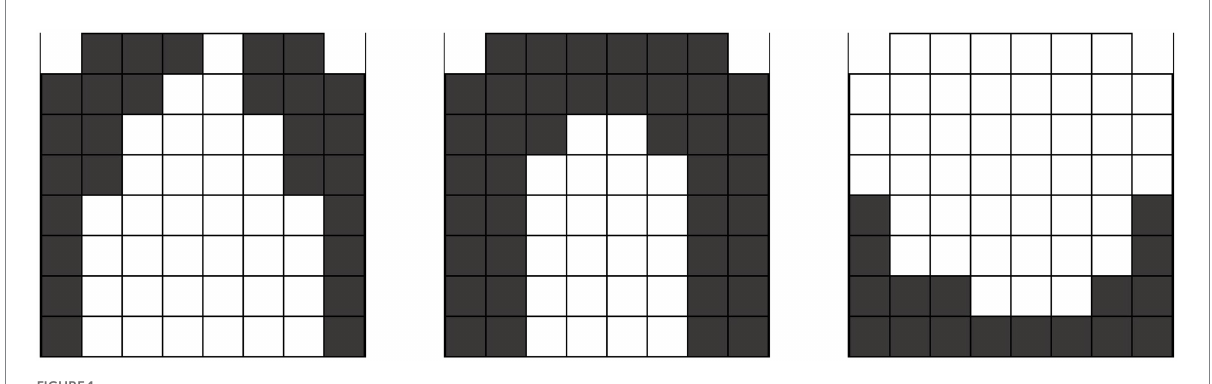
FIGURE 1 Tongue contact patterns for consonantal sounds. Left to right: alveolar grooved /s/ /z/; alveolar stop /t/ /d/ /n/; velar stop /k/ /g/